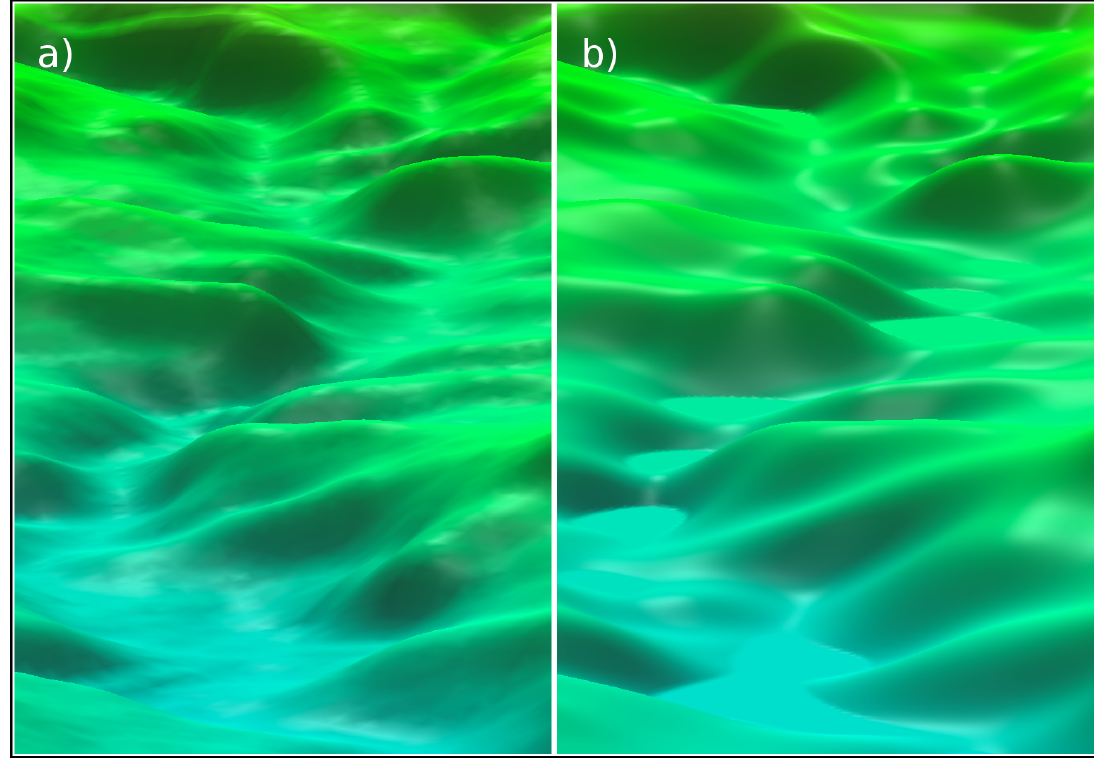
Figure 4. A comparison of the modern topography of a section of ( a ) the upper Rio Penaguila; and ( b ) the reconstructed Neolithic topography in the same area. The paleotopographic reconstruction resulted in a landscape of broad, U-shaped valleys, markedly different from the modern